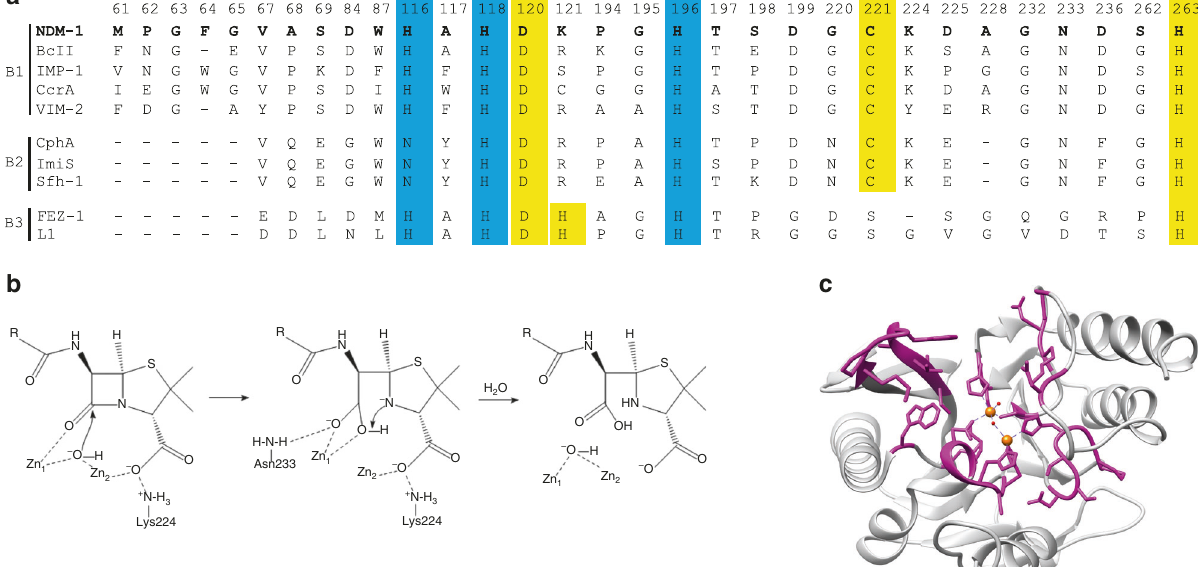
Fig. 1 Active site residues of metallo- β -lactamases. a Sequence alignment of representative metallo- β -lactamases from subclasses B1, B2, and B3. The amino acids highlighted in blue and yellow indicate the histidine and cysteine zinc binding site residues, respectively. NDM-1 residues are in bold. b Schematic representation of β -lactam substrate binding (penicillin), anionic intermediate stabilization, and product release in the active site of di-zinc metallo- β -lactamase NDM-1. The substrate binds to the active site through interaction of the carbonyl oxygen of the β -lactam ring with Zn1 and the carboxyl group on the fused ring with Zn2 and residue Lys224. A hydroxide ion stabilized by Zn1 and Zn2 attacks the carbonyl carbon of the β -lactam ring, leading to the formation of a carboxylate group and a nitrogen anion. The former is coordinated by Zn1 and the side chain of the conserved Asn233. The latter is stabilized by Zn2 and protonated coincident with or after C – N bond cleavage. The proton donor for the anionic nitrogen is shown as the newly formed carboxylate, however, the proton has also been proposed to be donated by a water. c Diagram of the NDM-1 β -lactamase structure highlighting active site residues for which random mutant libraries were created (magenta). The zinc atoms are represented as orange spheres. The fi gure was rendered with using coordinates from the Protein Data Bank accession code 3SPU